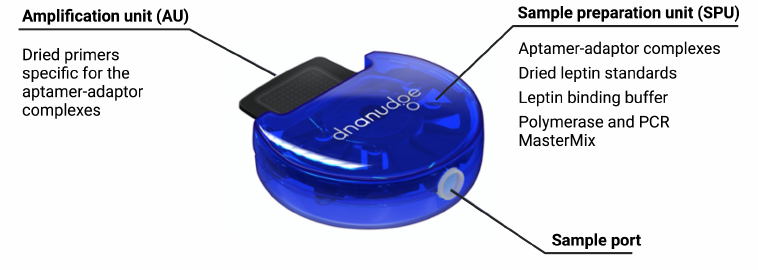
Figure 4. Cartridge, which consists of two main units: the sample preparation unit (SPU) and amplification unit (AU). Reprinted/adapted with permission from Ref. [12]. 2020, the